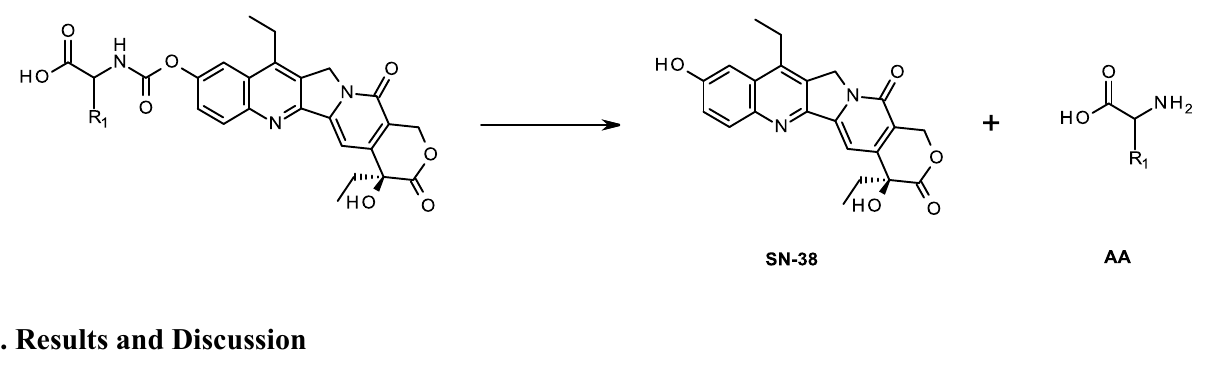
Figure 2. Conversion of target compound to SN-38.